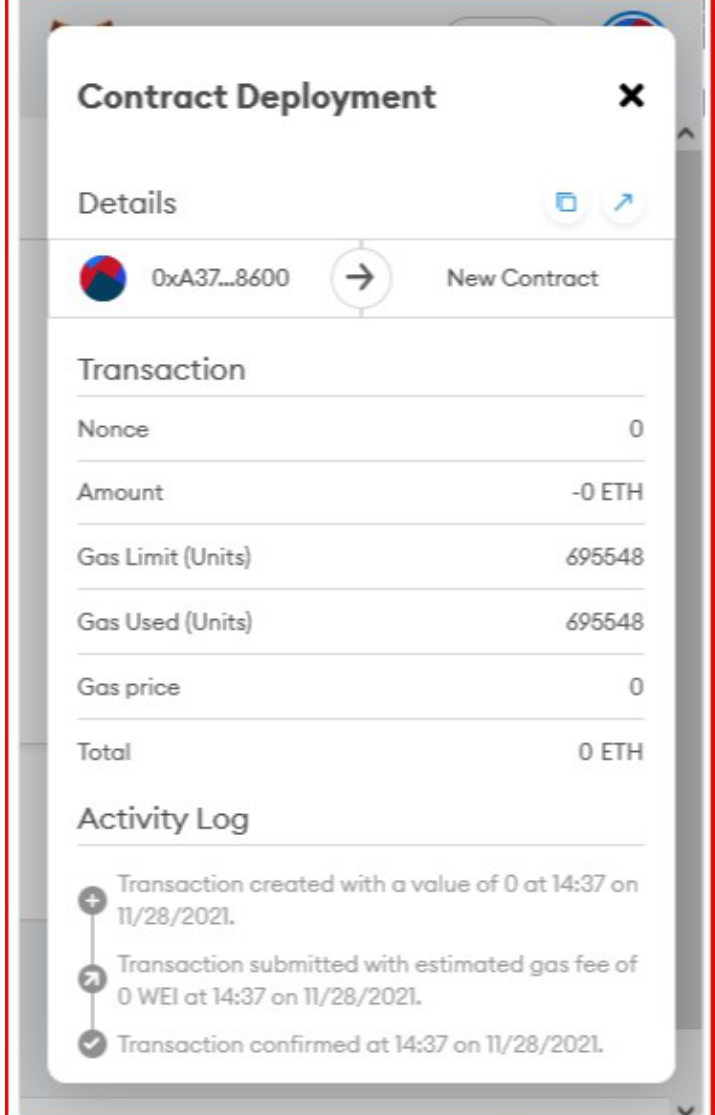
Figure 13. Smart contract deployment in